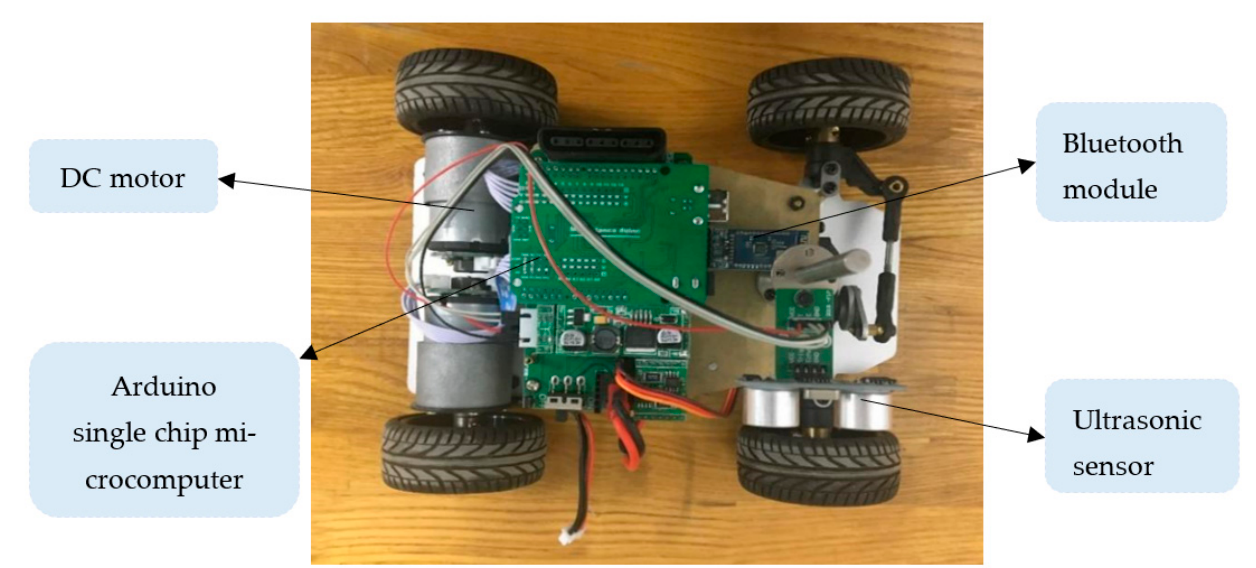
Figure 8. Experimental equipment—Arduino minicar.